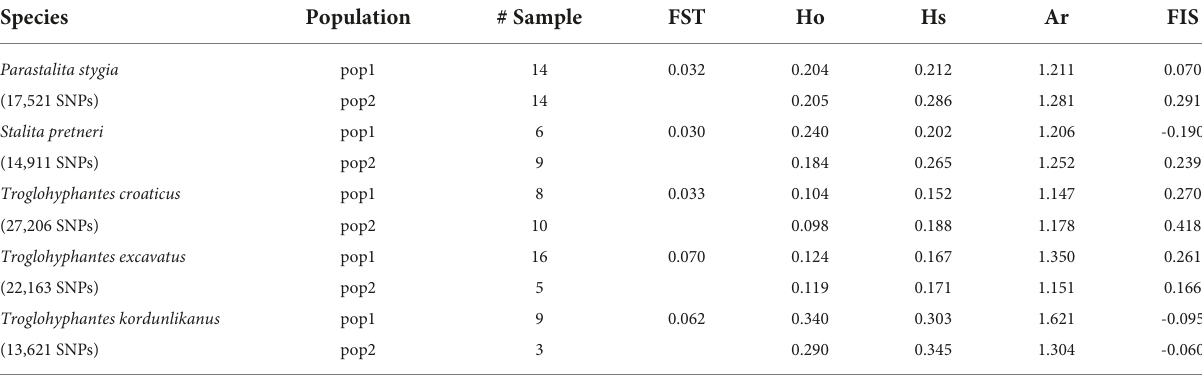
TABLE 2 Descriptive statistics estimated in each population identified by the best (cid:49) K criterion, including the observed heterozygosities (Ho), mean gene diversities within population (Hs), allelic richness (Ar), inbreeding coefficient (FIS) and genetic differentiation (FST). Species Population